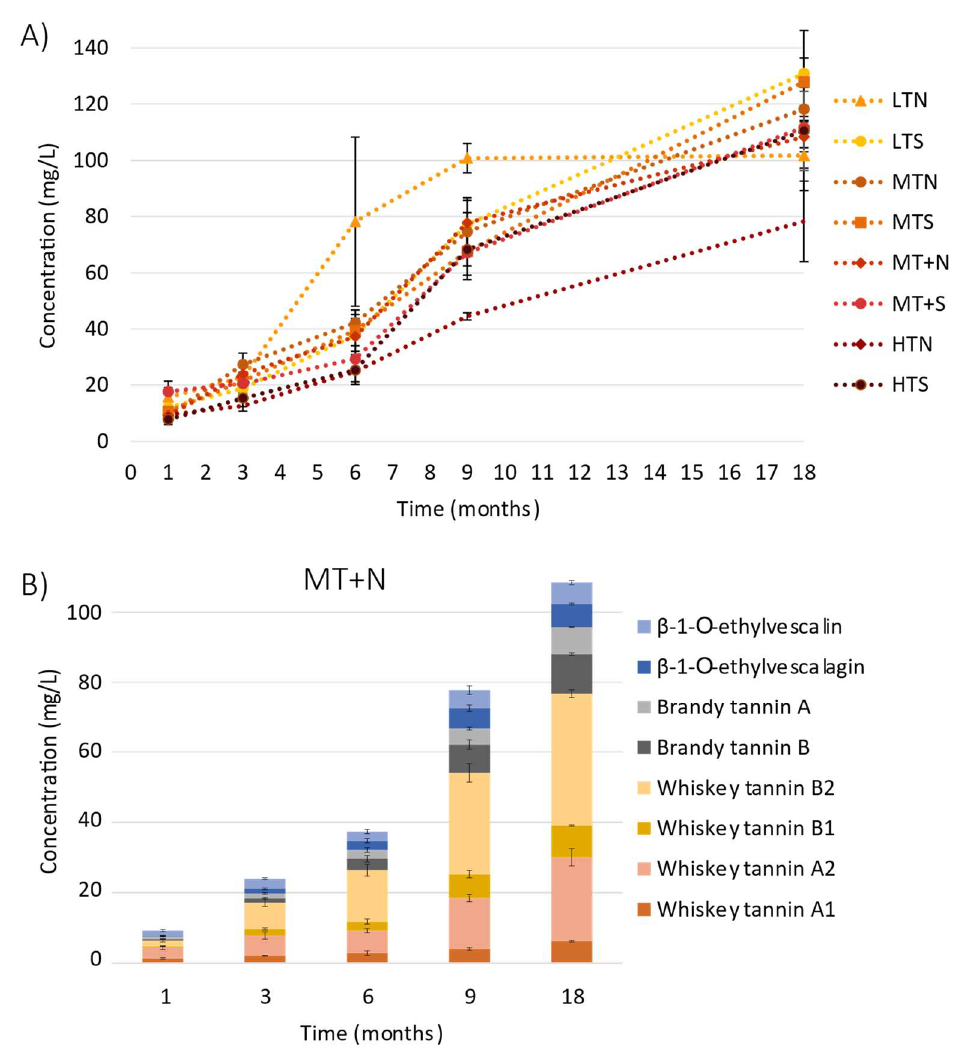
Figure 4. Sum of ellagitannin-derived spirit compound ( 9 – 14 ) concentrations in eau-de-vie during 18 months of aging in oak barrels manufactured with different toasting levels (LT: Light Toasting; MT: Medium Toasting; MT+: Medium Toasting Plus; HT: High Toasting; N: Normal; S: Slow) ( A )